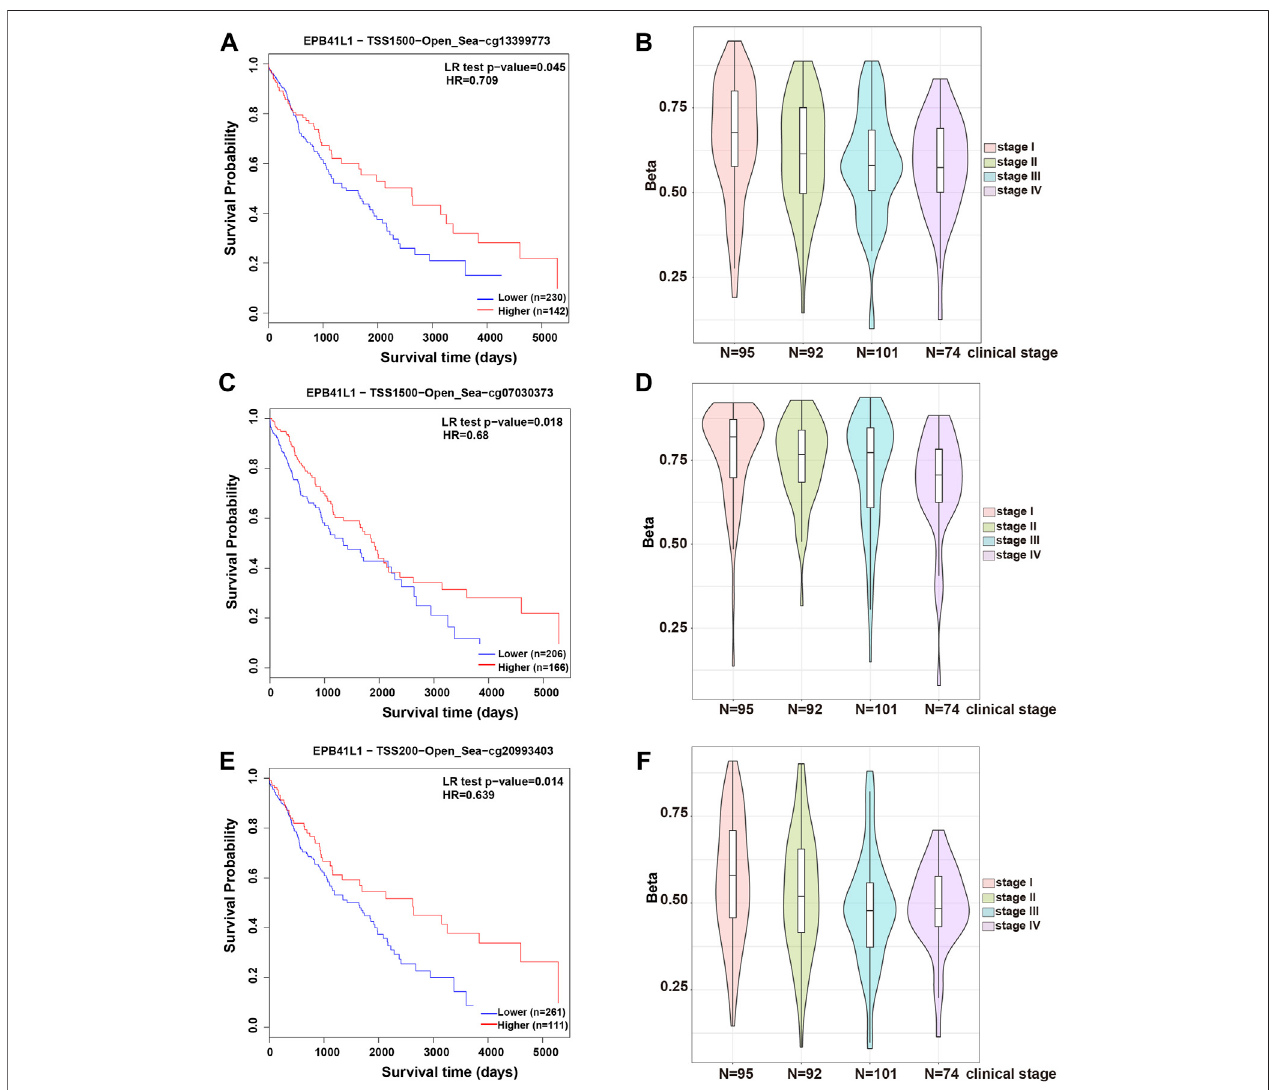
FIGURE 4 | Methylation levels and prognosis of the 4.1N/ EPB41L1 promoter in patients with LUSC. (A) Kaplan – Meier curves for cg13399773-4.1N showing survivalinlower(beta < 0.675,showninblue)andhighermethylationgroups(beta > 0.675,showninred)dichotomizedbythemaxstatmethod. (C) Kaplan – Meiercurves for cg07030373-4.1N showing survival in lower (beta < 0.796, shown in blue) and higher methylation groups (beta > 0.796, shown in red) dichotomized by the maxstat method. (E) Kaplan – Meier curves for cg20993403-4.1N showing survival in lower (beta < 0.611, shown in blue) and higher methylation groups (beta > 0.611, shown in red) dichotomized by the maxstat method. (B,D,F) Violin plots showing the methylation levels of cg13399773-4.1N, cg07030373-4.1N, and cg20993403- 4.1N among stage I – IV LUAD patients. Median methylation levels (show by a thick black line) and interquartile range were summarized by the boxplot within each violin plot. HR: hazard ratio; LR: log-likelihood ratio; LUSC: lung squamous cell carcinoma. Methylation levels were represented as beta values. Any beta value equal to or greater than 0.6 was considered fully methylated. Any beta value equal to or less than 0.2 was considered to be fully unmethylated. Beta values between 0.2 and 0.6 were considered to be partially